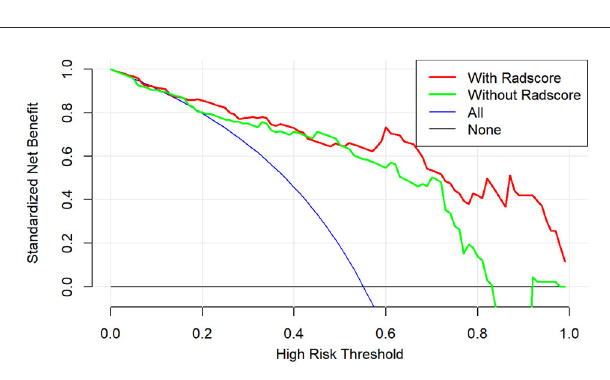
FIGURE6 Decision curve analysis of clinical benefit for clinical application for the clinical-radiomics model. RunEntropy, Left_Correlation, Right_SmallAreaLowGrayEmphasis, Right_Imc1, Right_Correlation, Left_GrayLevelNonUniformity_2,